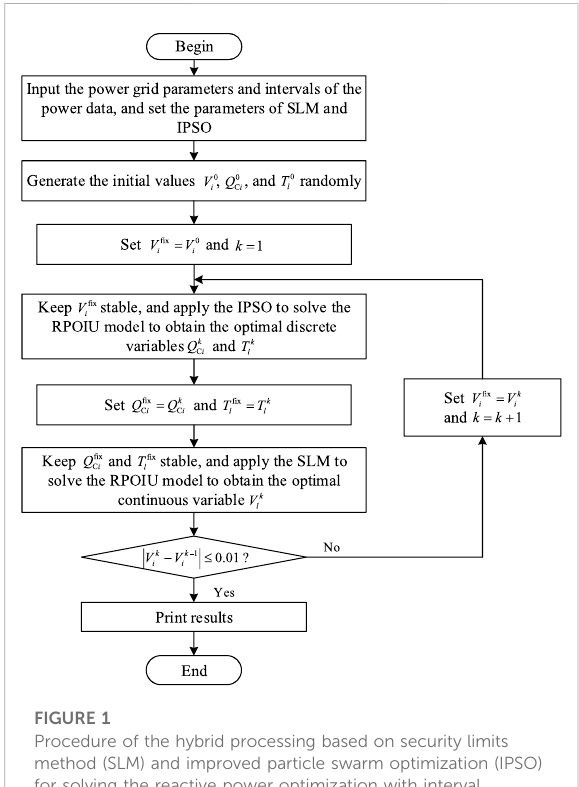
FIGURE 1 Procedure of the hybrid processing based on security limits method (SLM) and improved particle swarm optimization (IPSO) for solving the reactive power optimization with interval uncertainty (RPOIU)